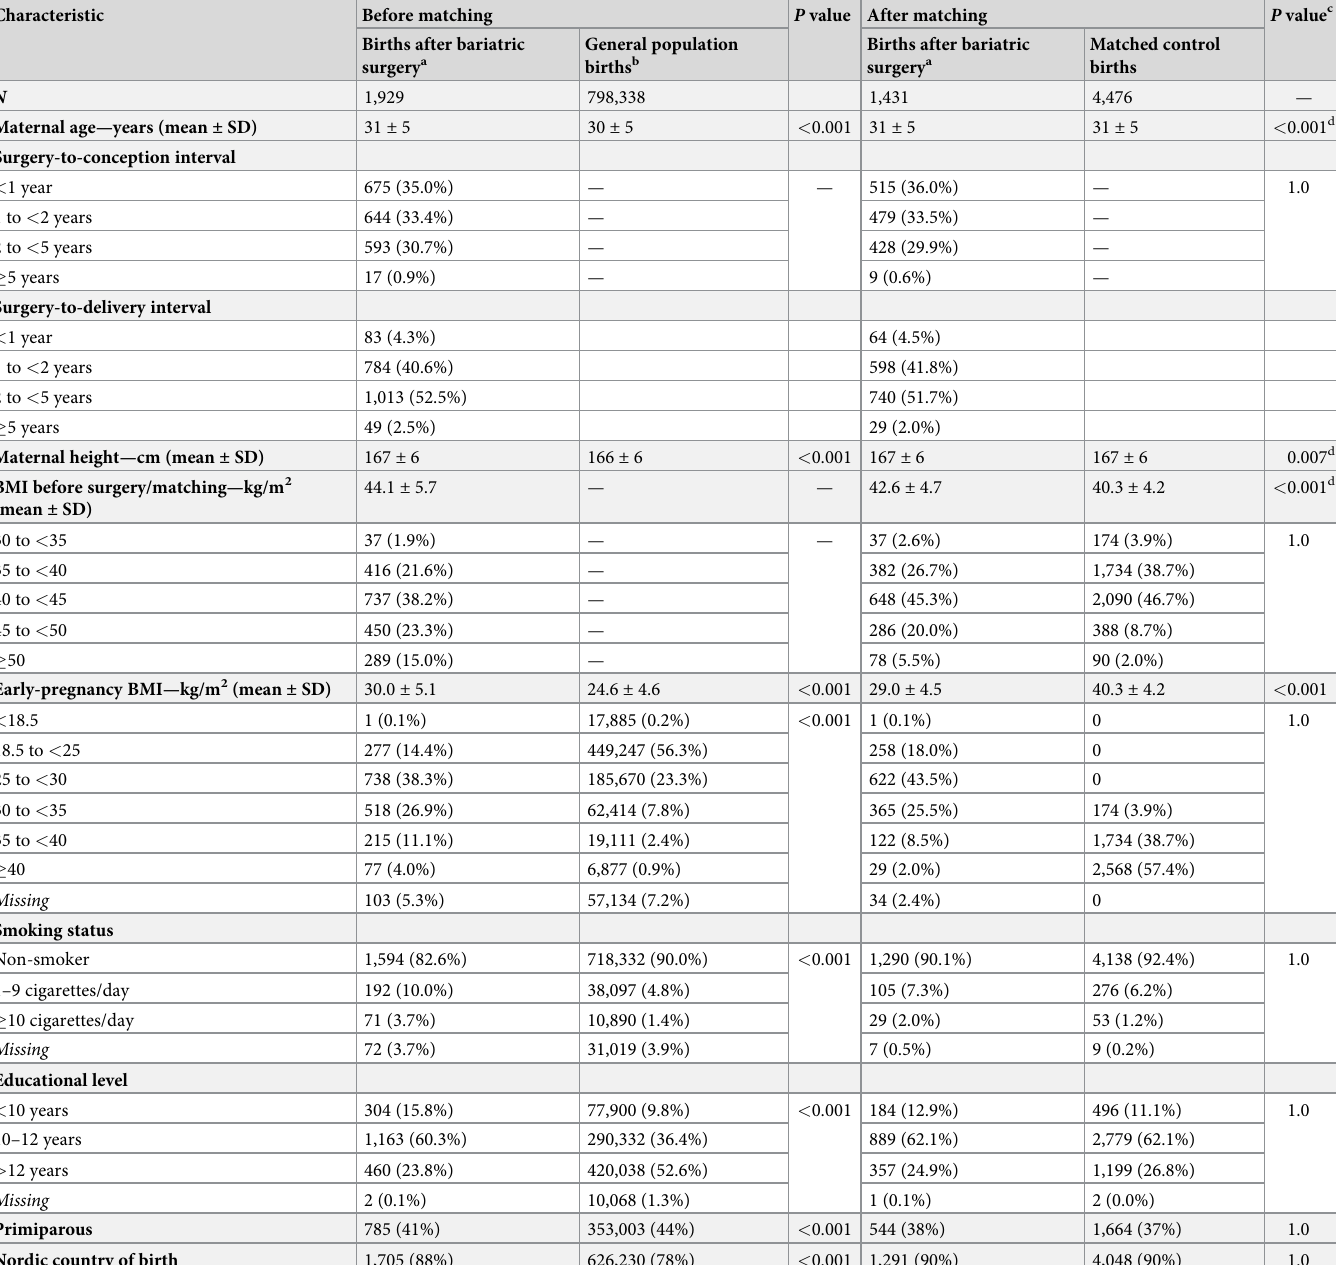
Table 1. Maternal characteristics in singleton live term births in Sweden between 2006 and 2013. Characteristic Before matching P value After matching P value c